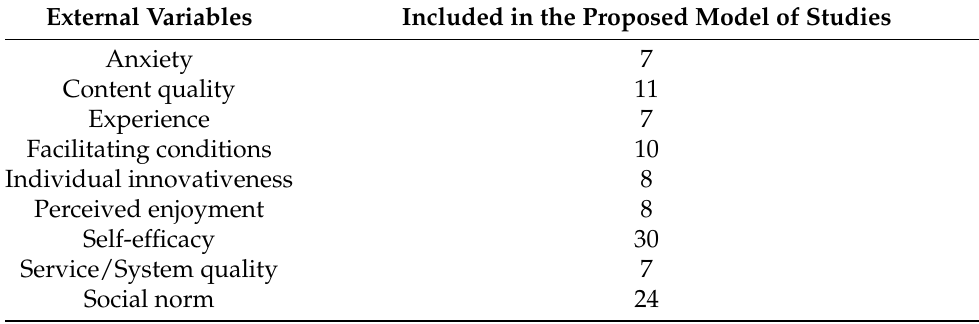
Table 2. Most commonly used external variables in TAM applications.